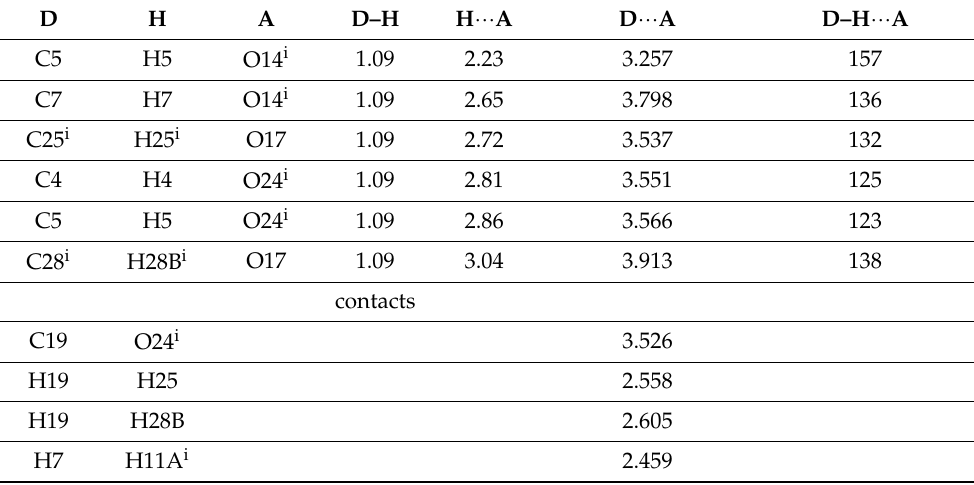
Table 5. The details of the interactions for the pair of the highest interaction energy in 2 ( i 1+x, y, z: 10 contacts with critical points). Upper part: geometrical details; lower: topological; D12: distance between two atoms; Gcp: kinetic energy density (kJ/mol/Bohr3); Vcp: potential energy density (kJ/mol/Bohr 3 ); Dcp1, Dcp2: distance from the first and the second atom to the critical